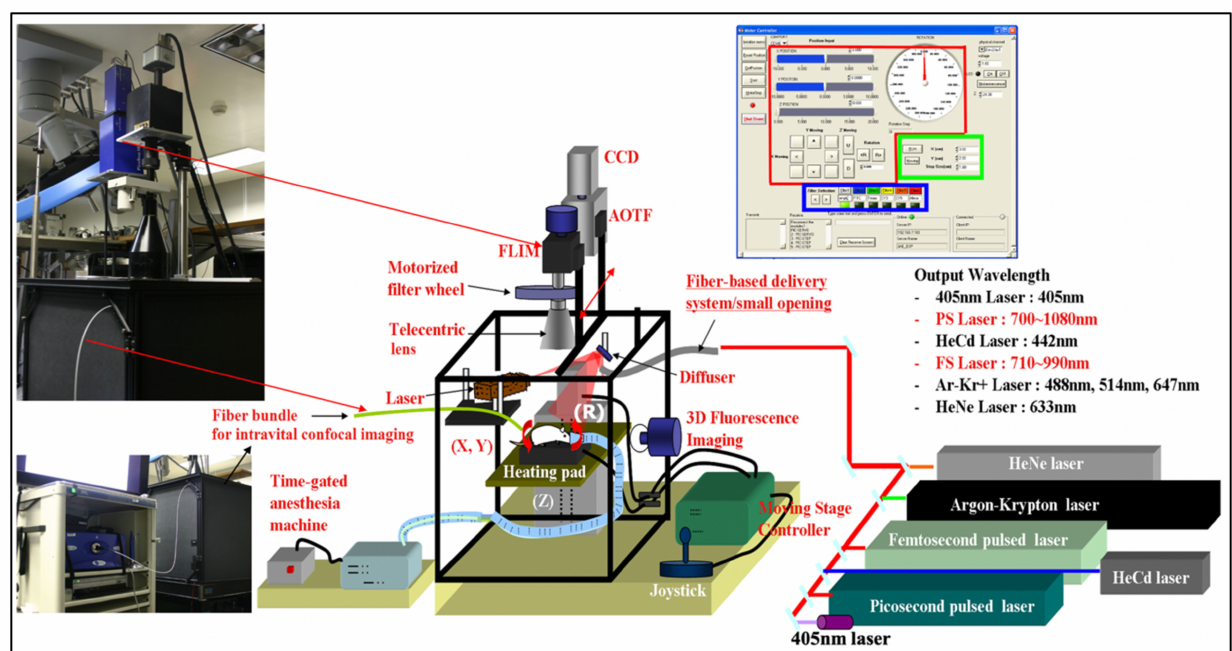
Figure 14. Multimode optical imaging system schematic, with pictures of key components [100,107]. The instrument is capable of several imaging modes, including fluorescence intensity/ratiometric fluorescence, spectral, lifetime, intravital confocal, two-photon, 3D, and bioluminescence imaging. The setup has 7 different lasers, allows for two-photon imaging in three modes (scanning, mosaic, and full-field), and has some other critical components (AOTFs, heating pad, and gated anesthesia for the animals, 3D/rotational stage allowing positioning of the animal under study, telecentric lenses, custom diffusers), mostly housed in a light-tight